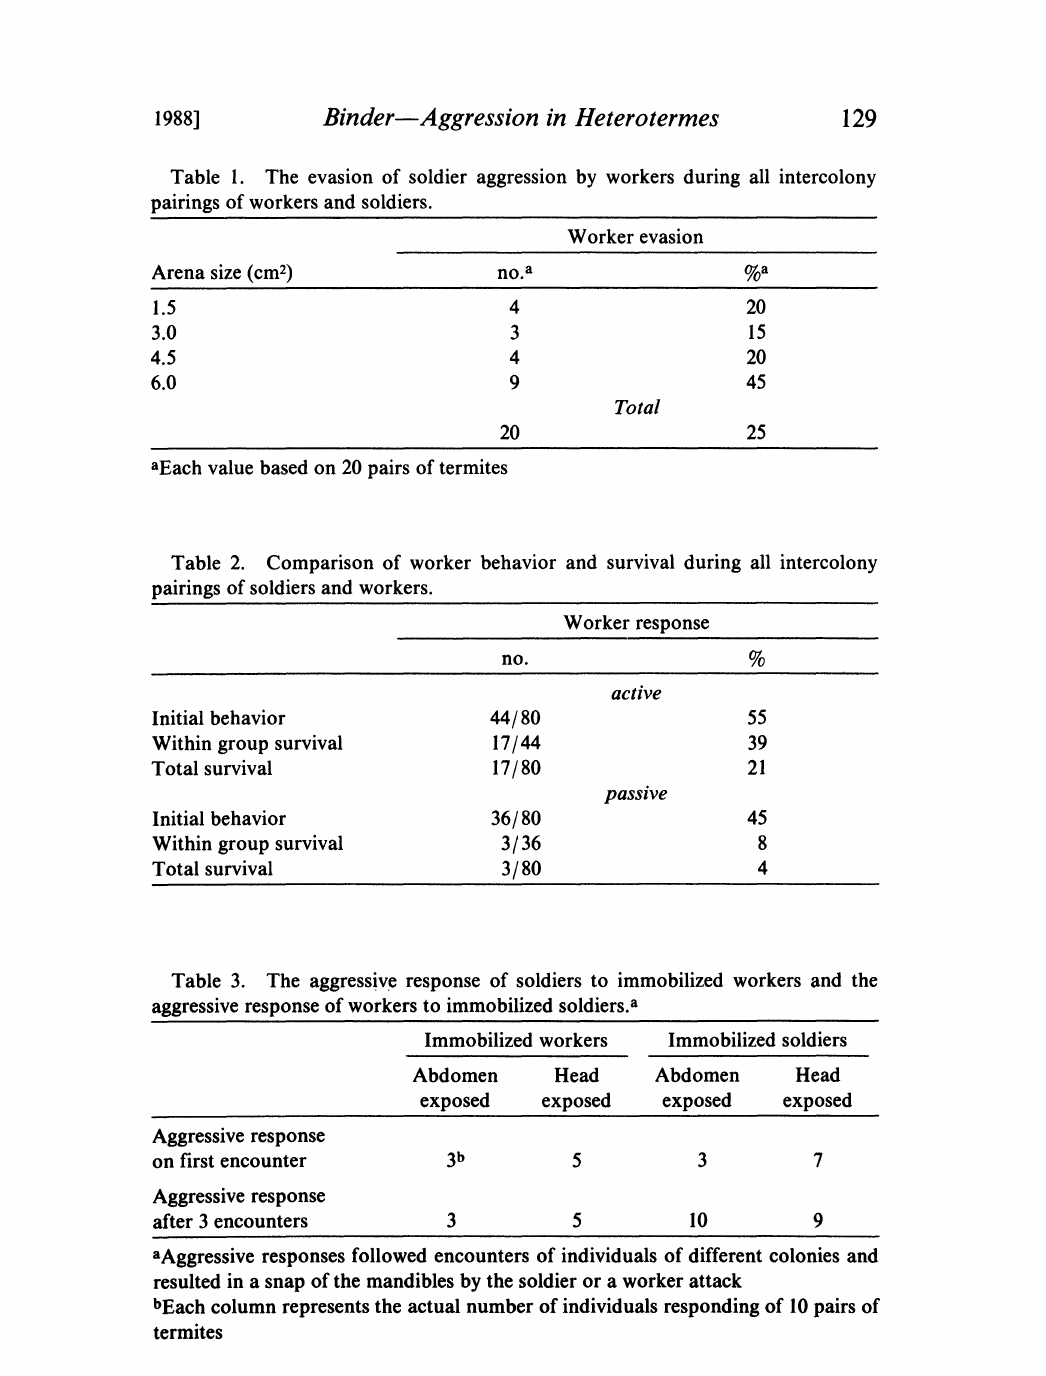
Table 1. The evasion of soldier aggression by workers during all intercolony pairings of workers and soldiers.